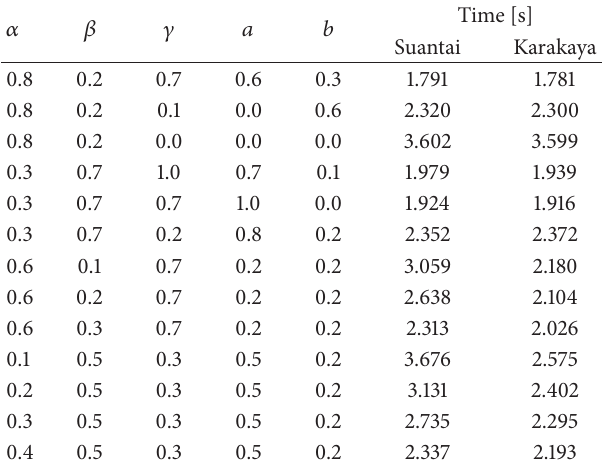
Table 8: Times of polynomiograph’s generation for 𝑝 1 using five parameters iterations.